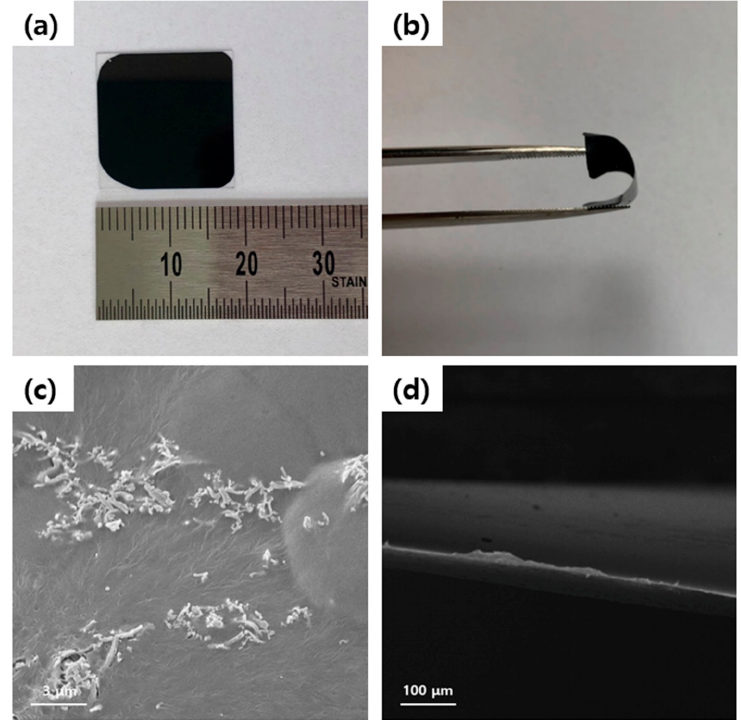
where σ c,s , σ c,p , σ s , and σ p are the electrical conductivities of the series-connected composite, the parallel-connected composite, the Ag 2 Se NWs, and the PEDOT:PSS matrix, respectively. The values used in the above equation are listed in Table S1, and the resulting curve using them is shown in Figure 4. ( a , b ). Digital photo image of Ag 2 Se NW/PEDOT:PSS composite films. ( c ) Surface and ( d ) Figure 4. ( a , b ). Digital photo image of Ag 2 Se NW / PEDOT:PSS composite films. ( c ) Surface and Figure 5. cross-sectional FE-SEM images of Ag 2 Se NW/PEDOT:PSS composite films. ( d ) cross-sectional FE-SEM images of Ag 2 Se NW / PEDOT:PSS composite films.